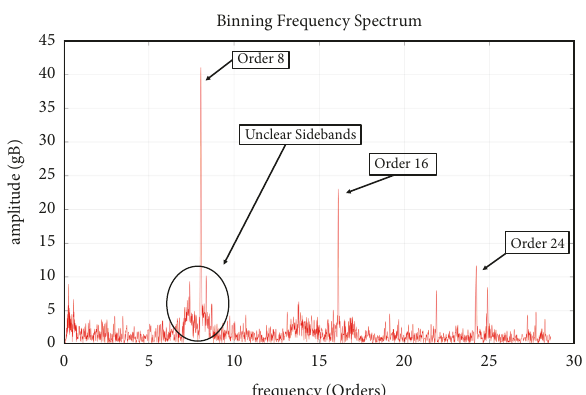
Figure 17: Noncyclostationary without damage.